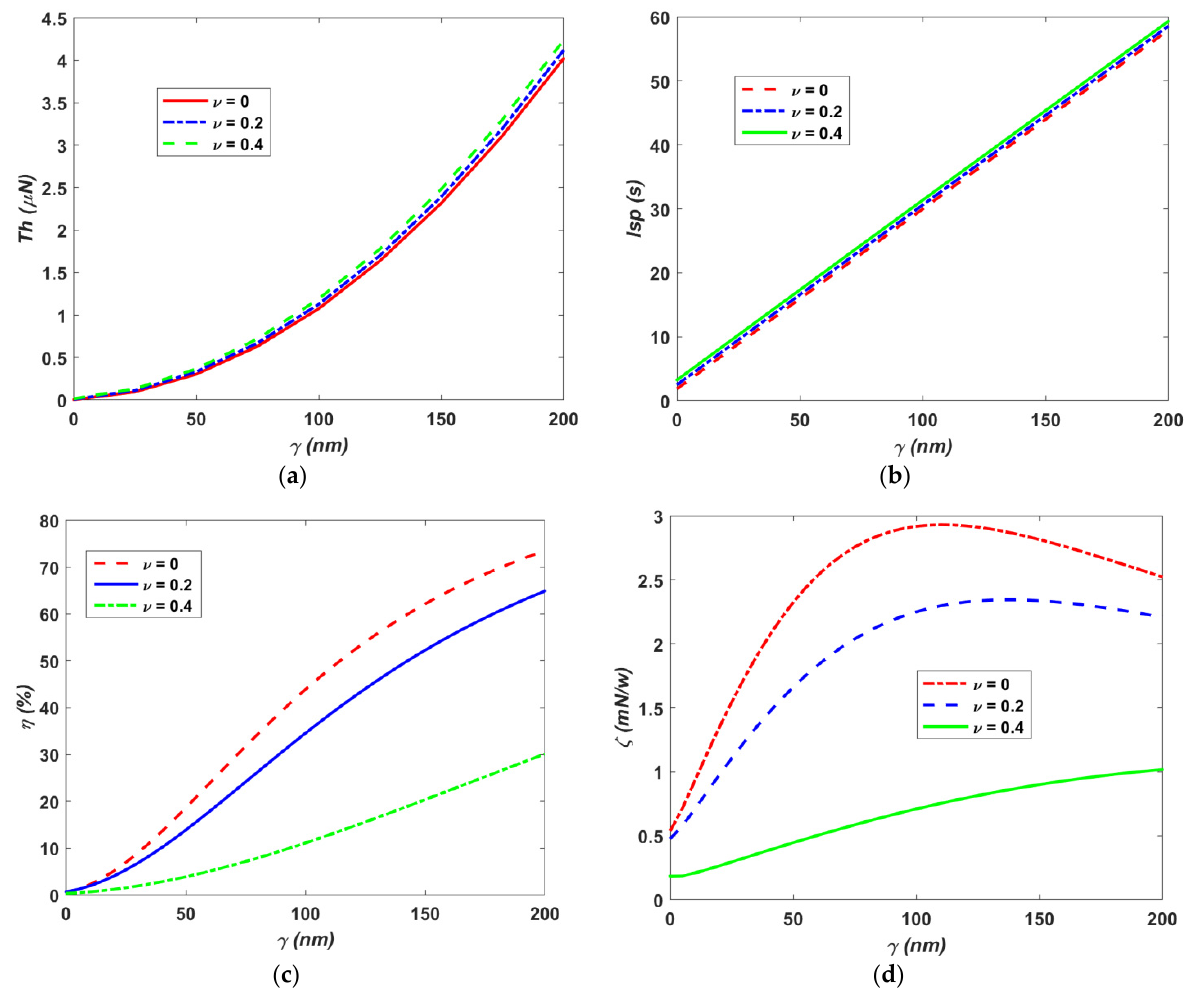
Figure 4. The variations of ( a ) thrust Th *, ( b ) specific impulse I sp *, ( c ) efficiency η and ( d ) thrust-to-power ratio ζ * of the space electroosmotic thrusters with different steric factors ( ν = 0, 0.2, 0.4) when λ * = 7.5 nm, λ * FCL = 25 nm, μ c = 10 4 Pa s/(km) 2 and ω = 5.4 mC/m 2 .